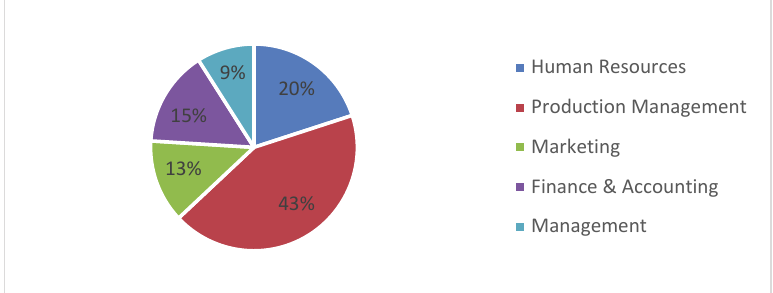
Fig. 1. Management challenges which SMEs were facing Source: JICA,